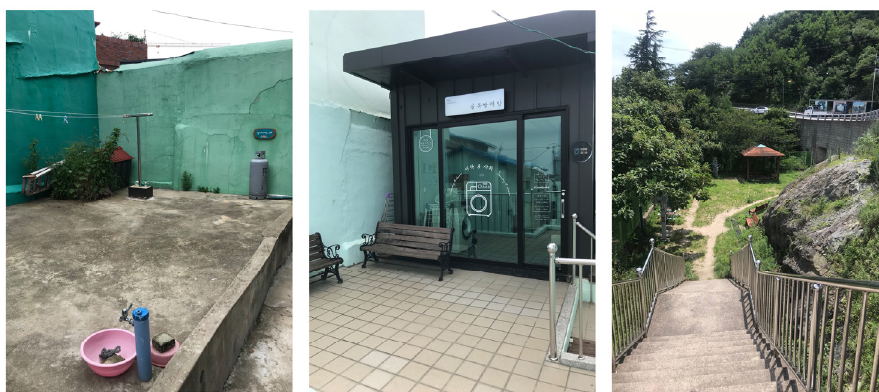
Figure 6. Semi-public urban pocket, laundry house and pocket park.